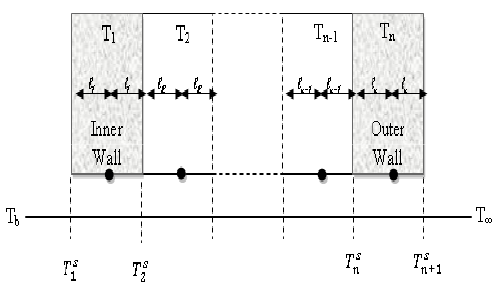
Figure 2: Distribution of temperature in a longitudinal section of a